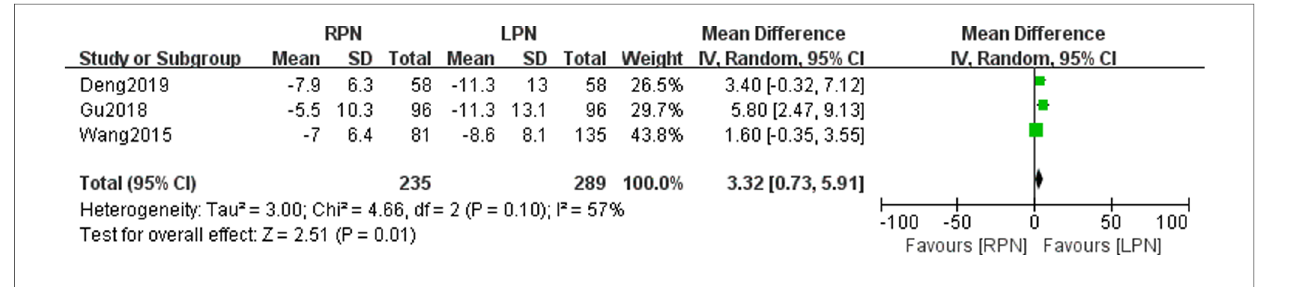
FIGURE 10 Forest plot for postoperative renal function between the RPN and